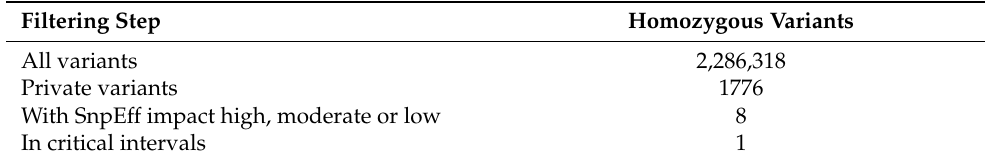
Table 1. Results of variant filtering in a DSRA affected dog against 789 control genomes.